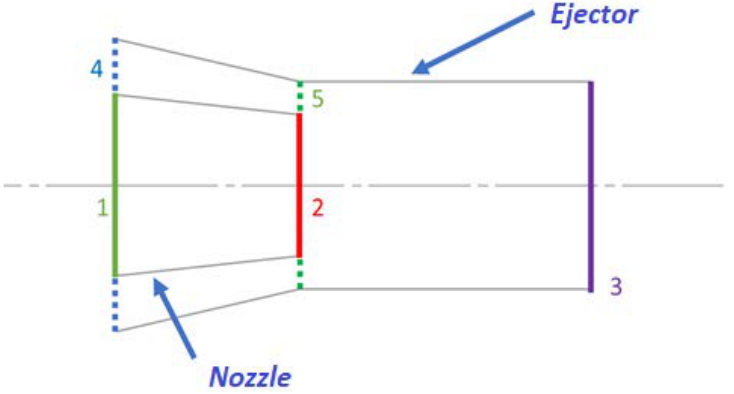
Figure 2. Principal scheme of an ejector, where 1 is the nozzle inlet, 2 is the nozzle exit, 3 is the ejector exit, 4 is the ejector inlet and 5 is the section between the nozzle exit and the ejector. With this model, the primary jet flow is ejected through the nozzle exit into the ejector, and the velocity is roughly constant, distributed through the whole of the cross-section of the way out of the nozzle. A sub-atmospheric pressure field is obtained, and as a consequence, a secondary flow is created in the rest of the cross-section area of the ejector at the first plane.